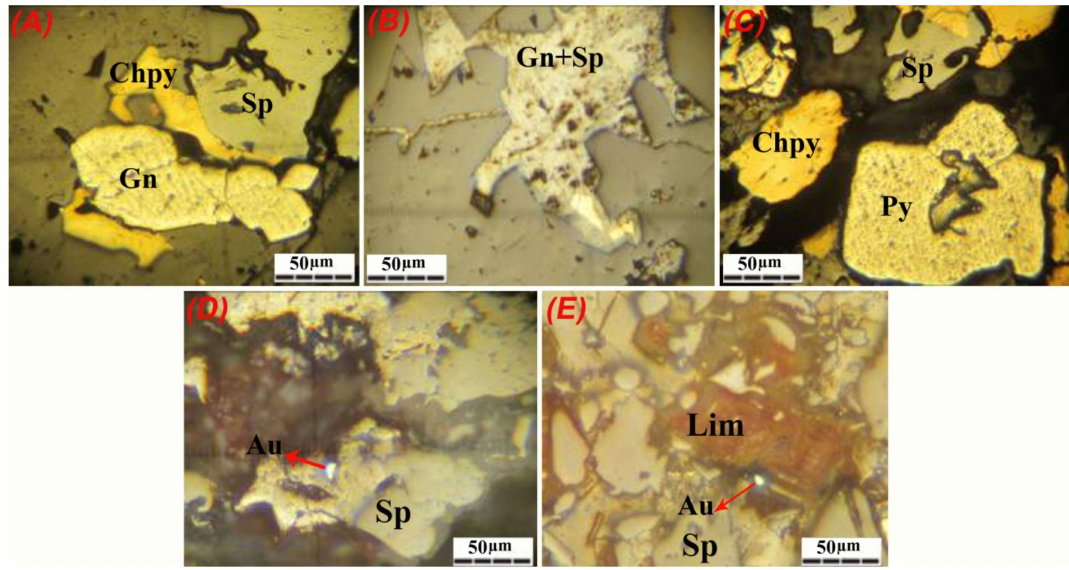
Figure 21. Microphotographs of sulfide mineralization in the Kalijan area (polished section). ( A ) Coarse anhedral sphalerite (Sp) in concordance with galena (Gn) and chalcopyrite (Chpy) (magnification: 10XPL); ( B ) Coarse anhedral sphalerite (Sp) intergrowth with galena (Gn) (white) and chalcopyrite (Chpy) (yellow) in quartz gangue (magnification: 10XPL); ( C ) Large anhedral form of chalcopyrite (Chpy), pyrite (Py) and sphalerite (Sp) (magnification: 20XPL); ( D ) Gold (Au) detected as an insulator inside the sphalerite (Sp) fracture (glossy yellow) (magnification: 20XPL); ( E ) Gold (Au) mineralization with a particle size of 10 microns along with an iron hydroxide (Lim) crystal surrounded by sphalerite (Sp) (magnification: 20XPL).